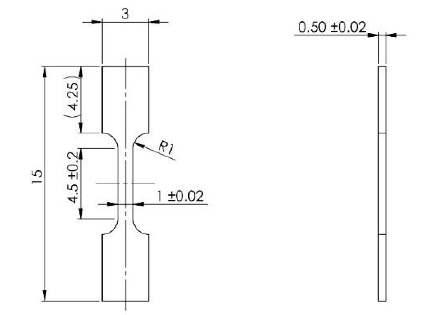
Figure 3. Dimensions of microsamples for tensile test (in mm).